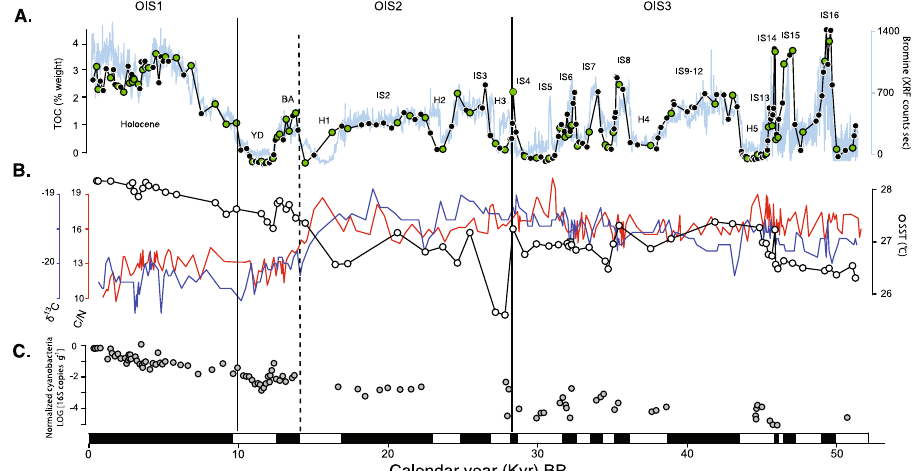
Figure 1. ( A ) Profiles of TOC and bromine, green circles indicate samples chosen for unamplified metagenomic sequencing. ( B ) Sea surface temperature (derived from the U K’ 37 index), C/N and δ 13 C profiles. Sapropelic (black) and organic-poor (white) intervals are depicted at bottom. YD: Younger Dryas, BA: Bølling- Allerød, IS: interstadial, H: Heinrich stadial, OIS: oxygen isotope stage. ( C ) Normalized qPCR quantification of cyanobacteria (predominantly Synechococcus ) 16S rRNA gene copies. Measurements are logarithmically transformed, after converting to a percentage of total bacterial 16S rRNA genes. Note that cyanobacteria decrease exponentially (R 2 = 0.89, P < 0.001) as a function of time. Solid lines separate oxygen isotope stages (OIS), and the dotted line marks the onset of the